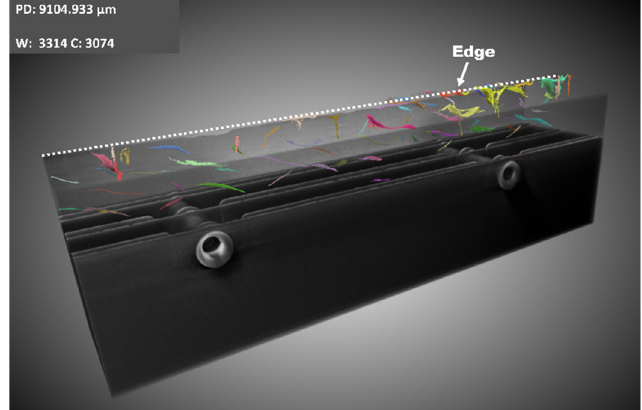
Figure 6. A total of 78 cracks are identified and represented by individual colors.